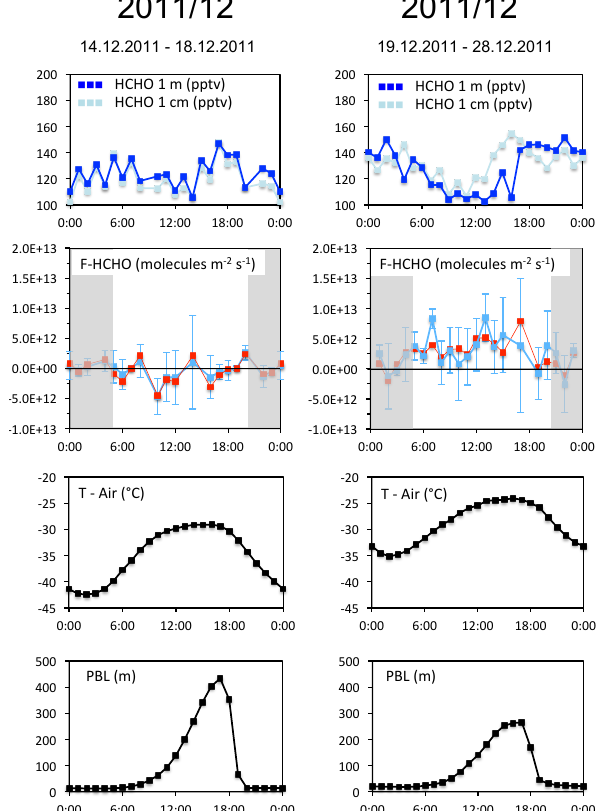
Figure 3. From top to bottom: mean daily course (hours are LT) of HCHO mixing ratios measured at 1m and 1cm above the ground, snow to air fluxes calculated from observed vertical gradients be- tween 1m and 1cm (arithmetic means in blue; median values in red), measured ambient air temperatures at Concordia, and simu- lated PBL